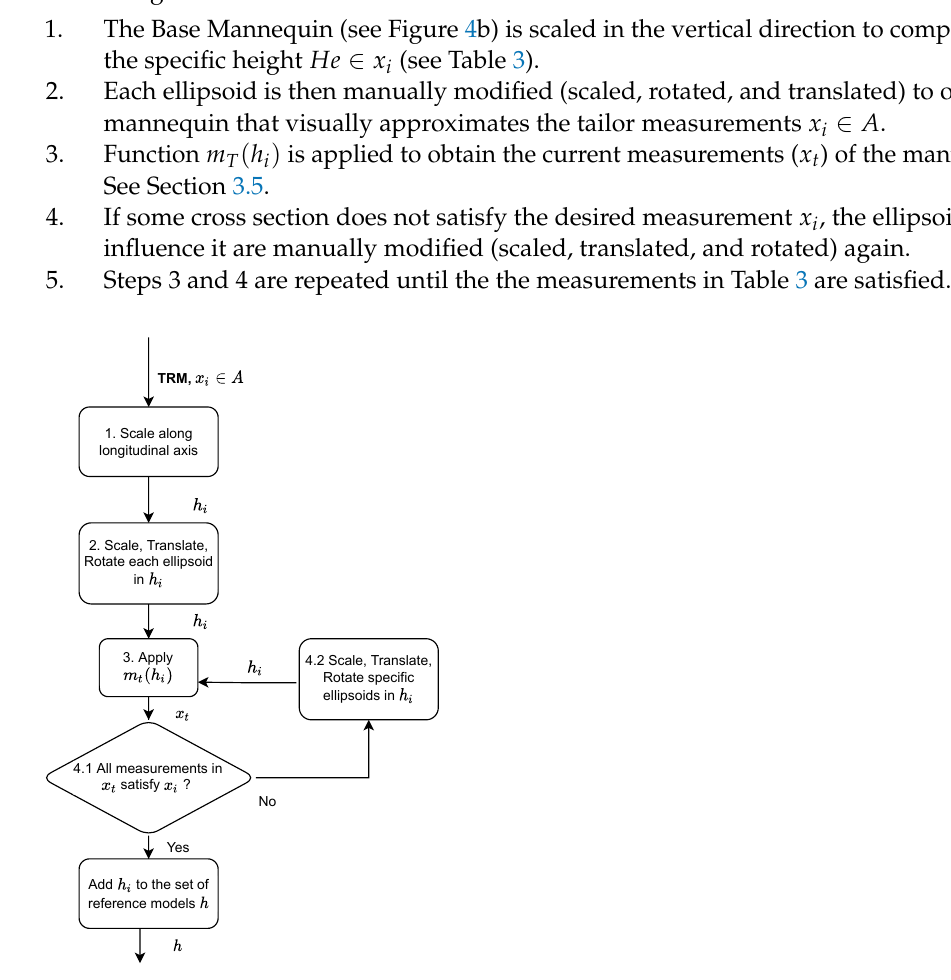
Figure 8. Flow diagram for the construction of RM based on BM . Process for a single RM i ∈ RM